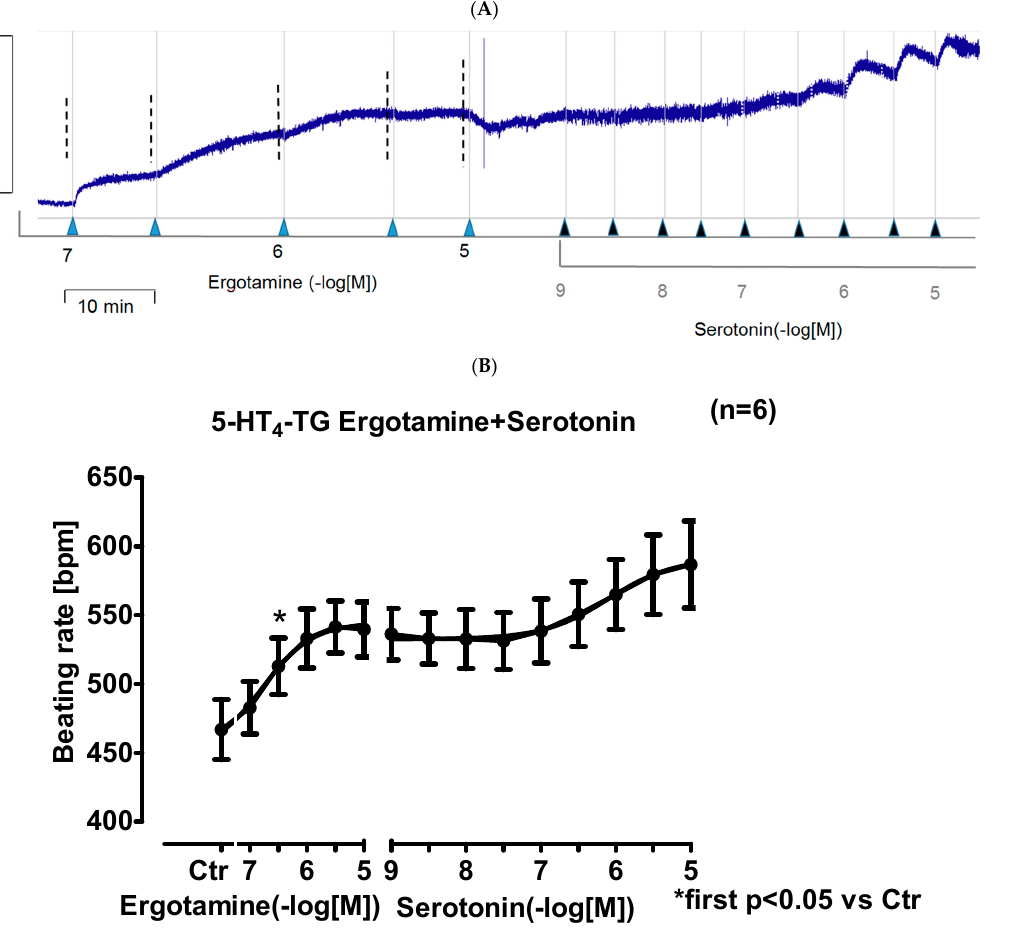
Figure 5. Ergotamine increases frequency in 5-HT 4 -TG. ( A ) Original recording: effect of ergotamine and serotonin on beating rate in spontaneously beating right atrial preparations from 5-HT 4 -TG. ( B ): Summarized effect of ergotamine or serotonin on beating rate in spontaneously beating right atrial preparations from 5-HT 4 -TG. Abscissae in Figure 5Bs give concentrations of ergotamine or hista- mine in negative decadic logarithms, respectively. Horizontal bar in Figure 5A indicates time axis in minutes (min). In Figure 5B first significant differences versus control (Ctr; pre-drug value) is indicated in asterisks. “n” indicates number of experiments.